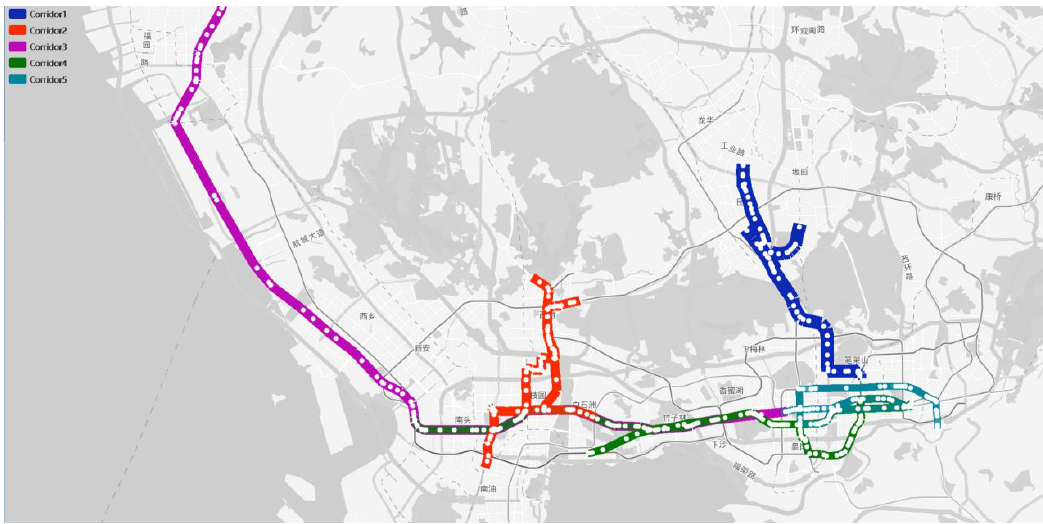
Figure 5. Public transit corridors for weekday peak hours (8:00AM–10:00AM).